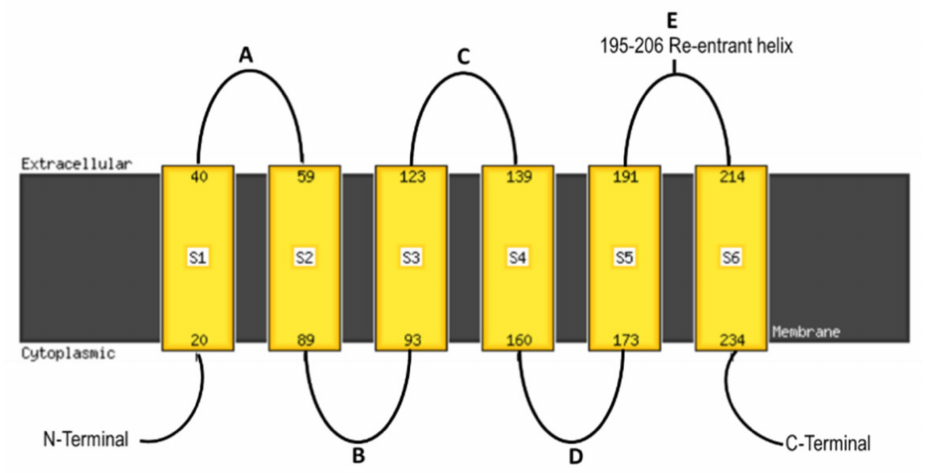
Figure 1. Transmembrane helix prediction for the HvTIP2;3 protein sequence of barley (HORVU7Hr1G081770) that was obtained using Phyre2 software [14]. S1–S6: six transmembrane helices, A–E: five connecting inter-helical